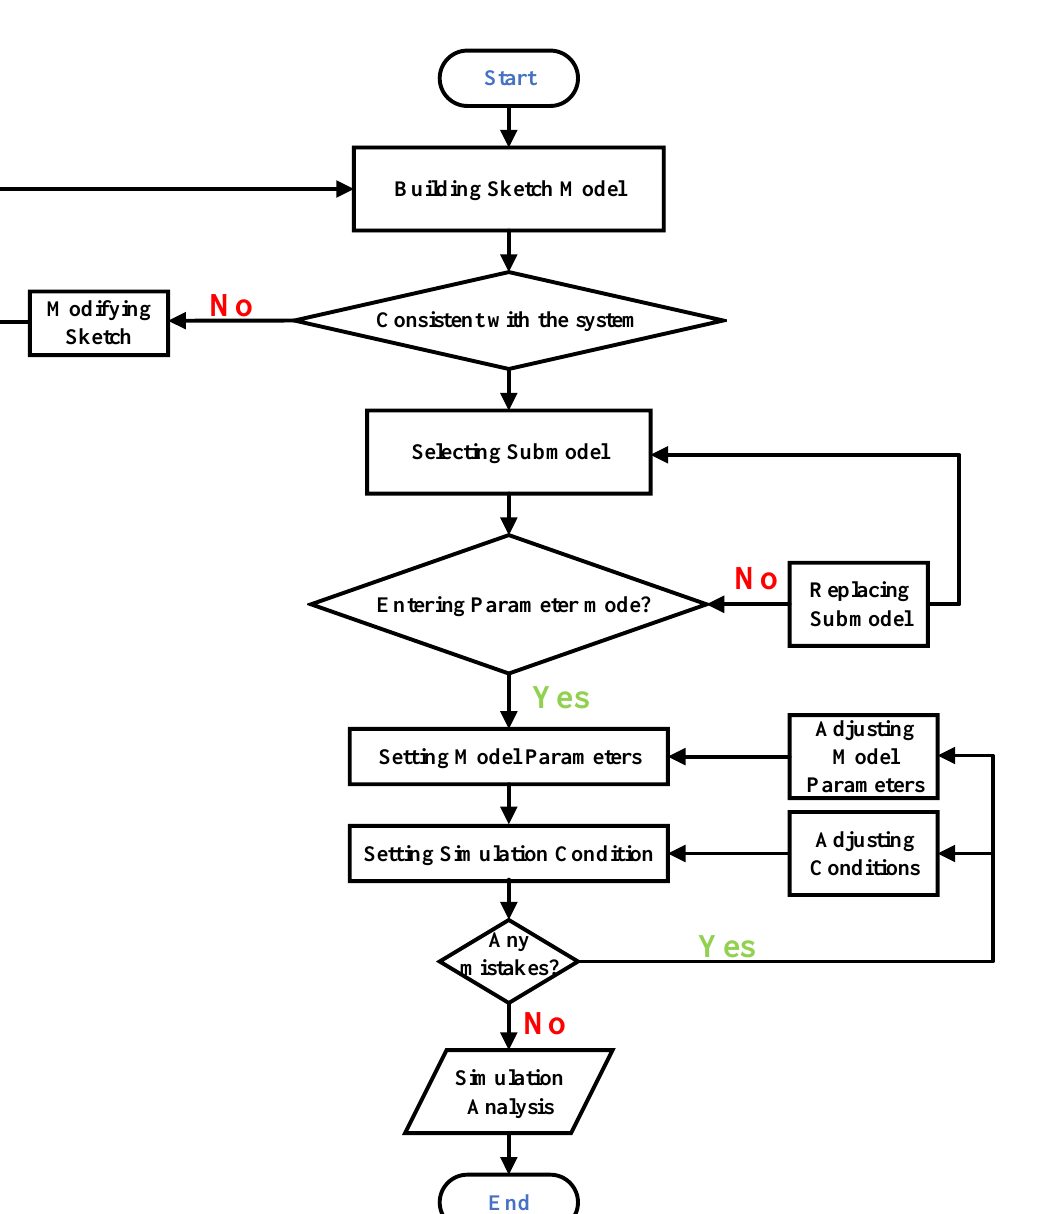
Figure 8. Flow chart of AMESim simulations.